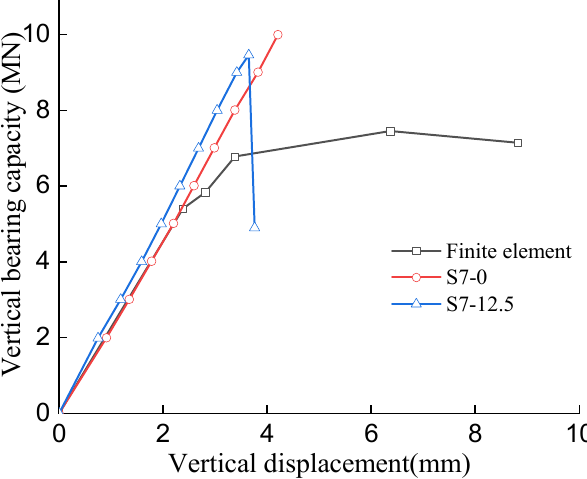
Figure 13. Comparison of the vertical bearing capacity.